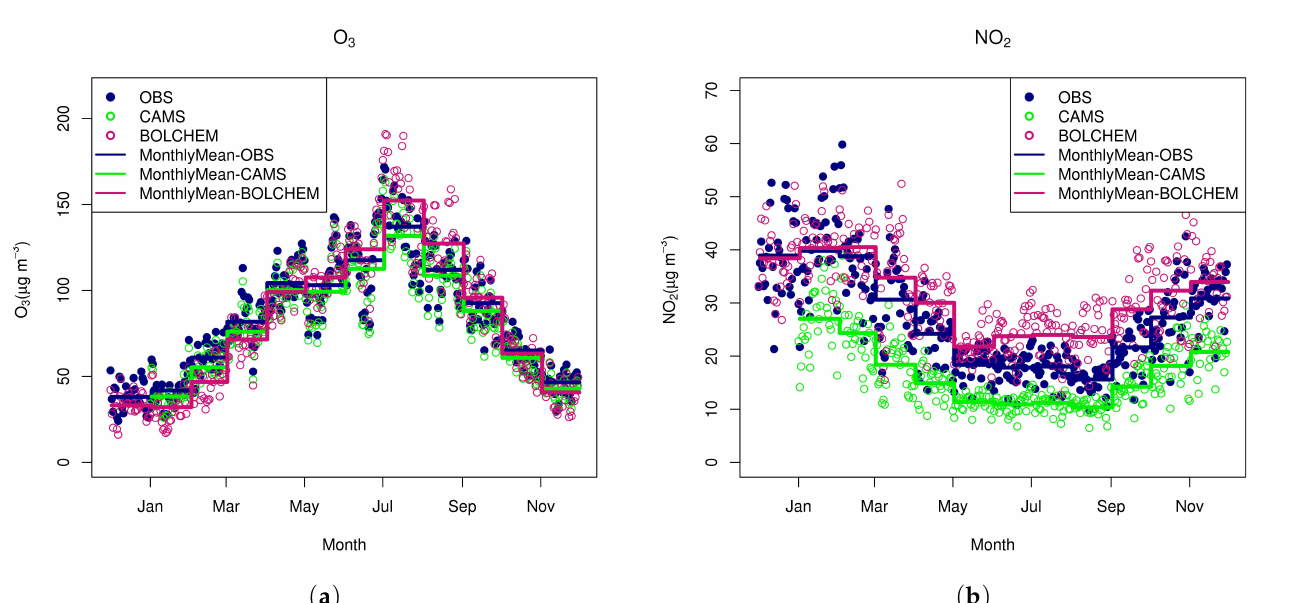
Figure 14. Average values calculated overall background stations for the period of interest, for O 3 ( a ) and NO 2 ( b ) both for BOLCHEM (from December 2009 to November 2010) and for CAMS ensemble median (from January 2010 to November 2010) model. Maximum daily 1-h average concentration ( µ g m − 3 ) for O 3 and daily mean values concentration ( µ g m − 3 ) for NO 2 are reported through blue filled circles (observations) and empty circles (red for BOLCHEM and green for CAMS). The monthly mean of the reported concentration is represented with solid line (red line represents simulated value, while blue line represents measured